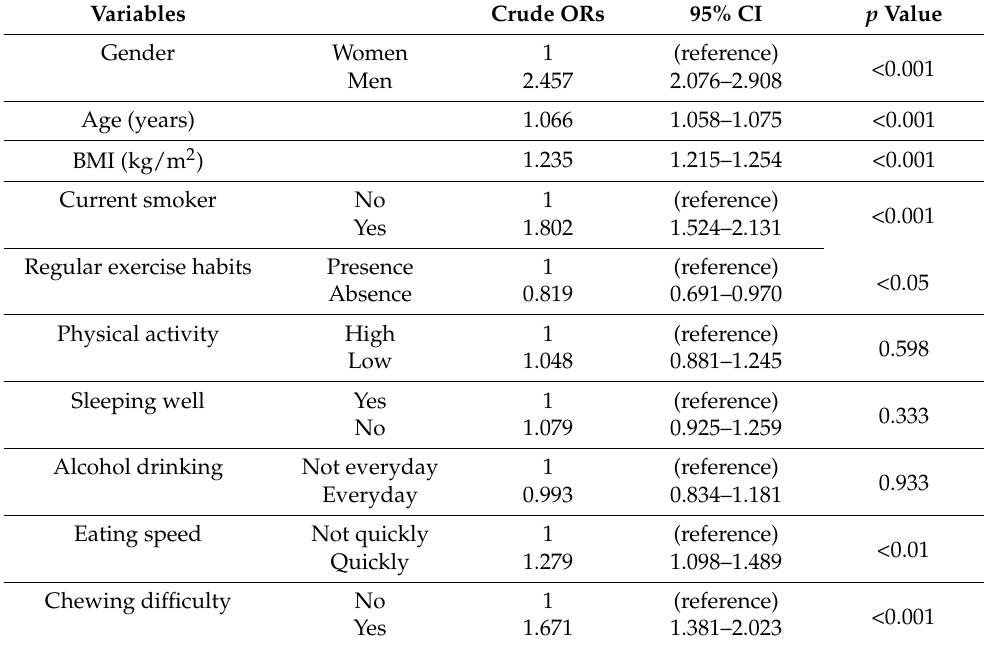
Table 3. Crude odds ratios and 95% CI for high HbA1c levels according to the analyzed factors in all